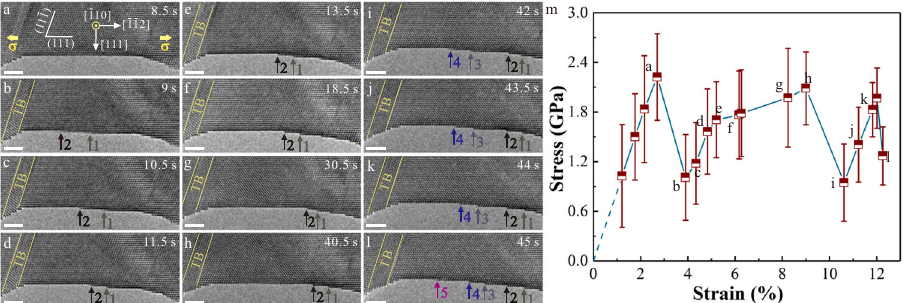
Fig. 5 Surface atom diffusion induced abnormal softening during plastic fl ow in an Ag NW. a Pristine Ag NW with a diameter of 13.1 nm as viewed along ½ (cid:2) 110 (cid:5) and loaded along ½ (cid:2) 1 (cid:2) 12 (cid:5) -orientation at room temperature and a strain rate of ~ 10 − 3 s − 1 . b Two surface steps (steps 1 and 2) formed by full dislocation activities. c-h , Surface-diffusion-assisted migration of surface steps (steps 1 and 2) to the right side of the NW during tensile loading. i Two new surface steps (steps 3 and 4) in NW formed by full dislocation activities. j-l , Sequential TEM images showing the plastic fl ow of the Ag NW with a small number of surface diffusion. All scale bars are 2 nm. Each surface step is tracked by an arrow of a speci fi c color. m Lattice stress versus applied strain curve during tensile loading corresponding to the sequence in a – l . The initial strains were nominalized by subtracting the plastic strain in the previous plastic deformation history. The error bars represent the variations of the measured lattice stresses at different locations of the